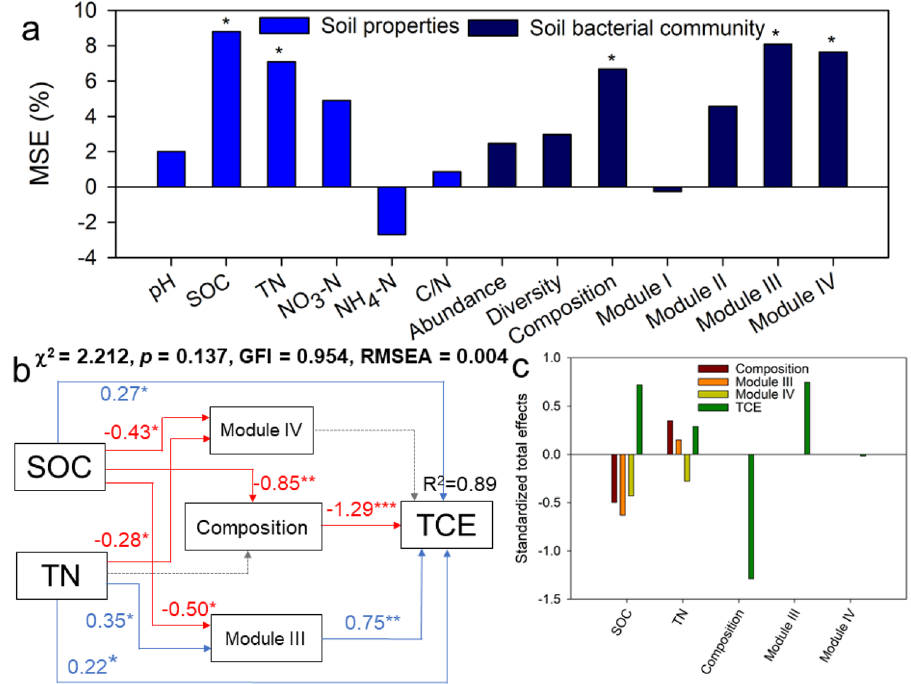
Figure 6. The significant predictors of soil properties and the bacterial community to total carbon emission (TCE) via random forest analysis ( a ). The bacterial community is represented by abundance (copy number of 16S rRNA), diversity (Shannon index), composition (the first principal coordinate), and module III and VI (module eigengenes) of the bacterial networks. (b) Effects of soil properties and the bacterial community on TCE as estimated using structural equation modeling (SEM) analysis. Blue and red lines indicate significant positive and negative relationships, respectively. ( c ), The standardized total effects for the indexes in the SEM. TN, total nitrogen; SOC, soil organic carbon; NO 3 -N, nitrate nitrogen; NH 4 -N., ammonia nitrogen, C/N ratio, SOC to TN ratio. *** p < 0.001; ** p < 0.01; * p <